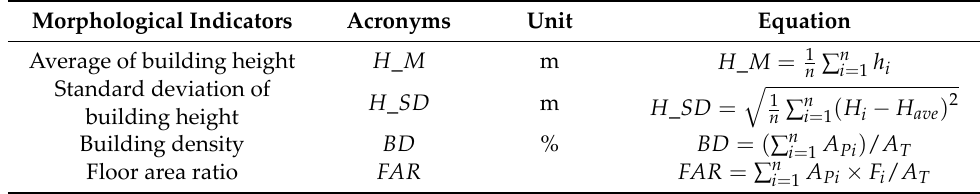
Table 3. Information of four morphological